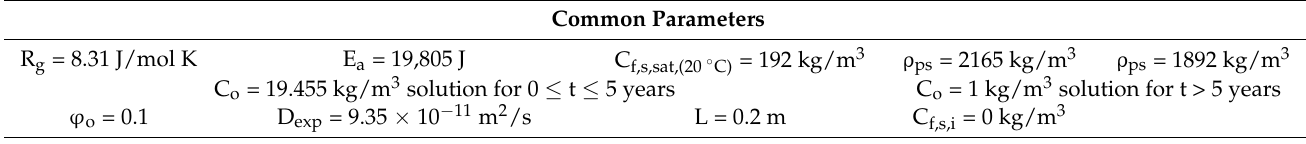
Table 5. Saturated problem. Data of the second